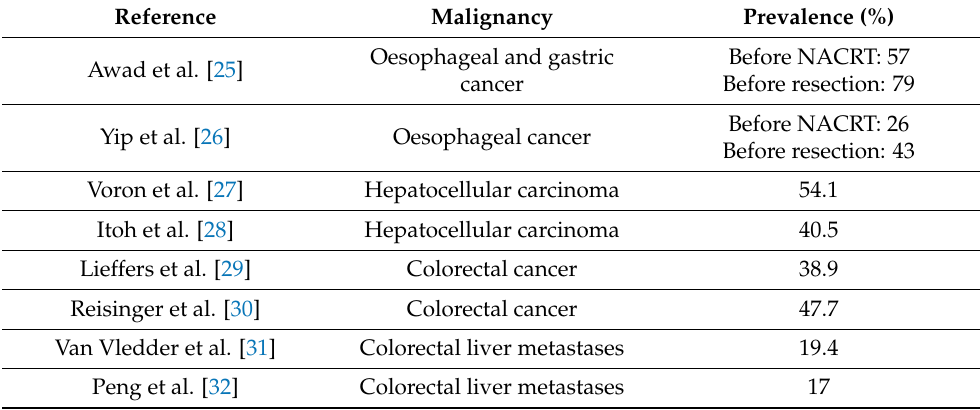
Table 1. Prevalence of sarcopenia in gastrointestinal